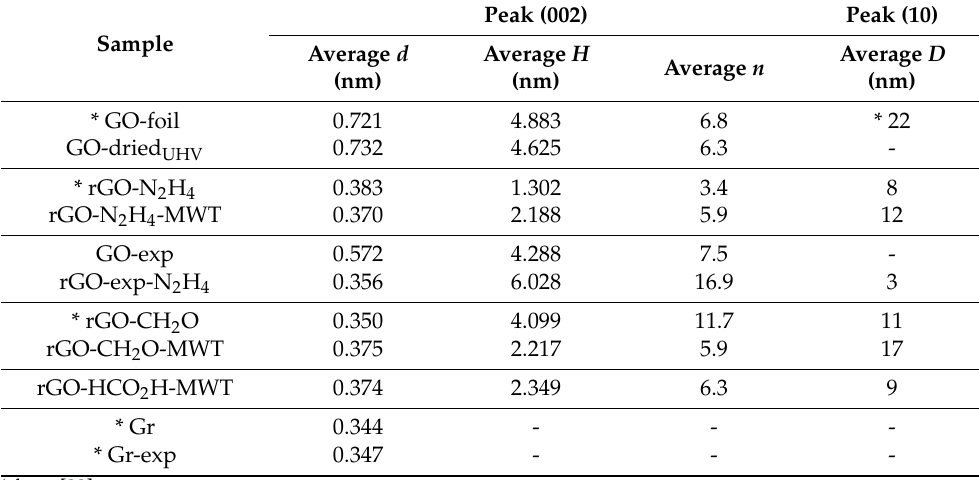
Figure 2. XRD patterns of: ( a ) GOs, rGO and graphites, ( b ) rGOs obtained using different reducing agents and microwave treatment (MWT). Table 1. GOs and rGOs parameters obtained from XRD patterns, i.e., average distance between graphene layers ( d ), average height of flakes ( H ), average number of graphene layers ( n ) and average diameter of flakes ( D